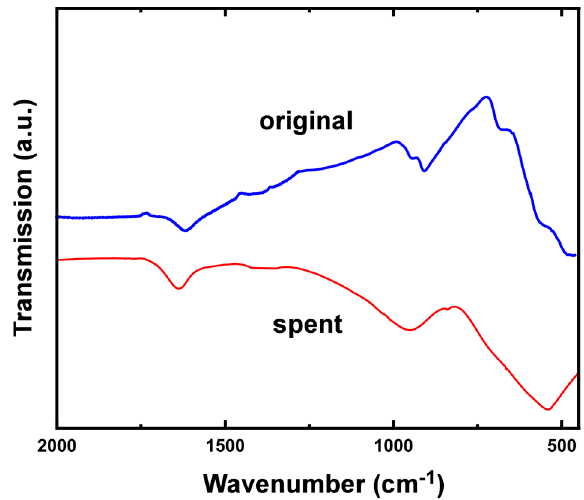
Figure 4. FT-IR spectra of spent and corresponding original adsorbent.